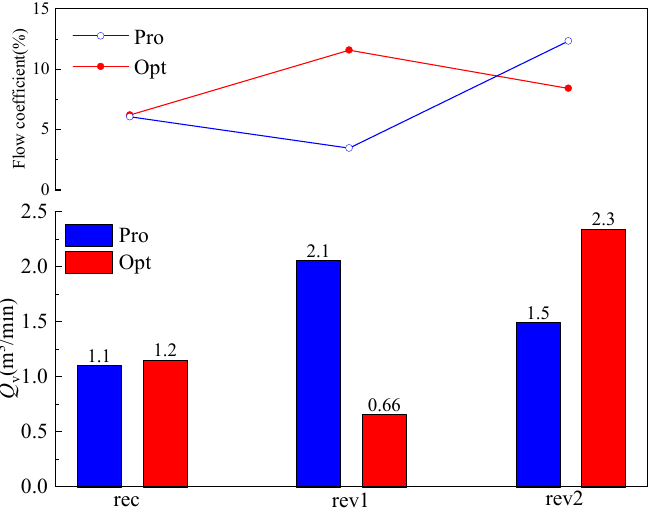
Figure 20. Airflow in the area near the volute tongue.